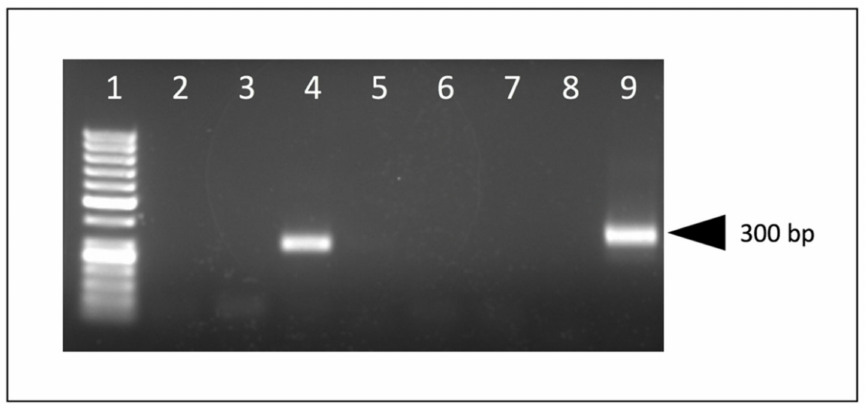
Figure 5. Nested PCR, agarose gel electrophoresis. An appropriate-sized PCR amplicon is present in samples derived from the kidney of goat A. Molecular weight markers (lane 1), kidney (positive, lane 4), other caprine tissue samples (negative, lanes 2, 3, 5, 7), water template (negative control, lanes 6 and 8), plasmid DNA (positive control, lane